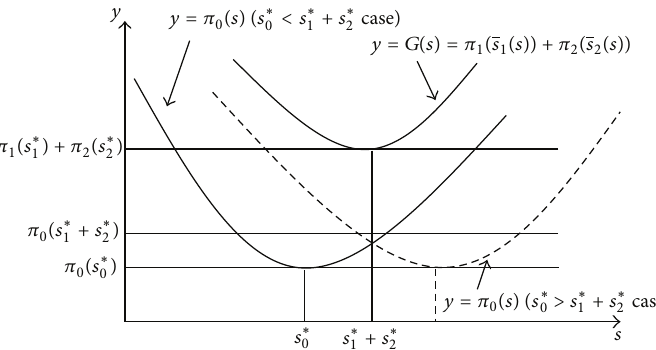
Figure 2: A graphical illustration of (19).